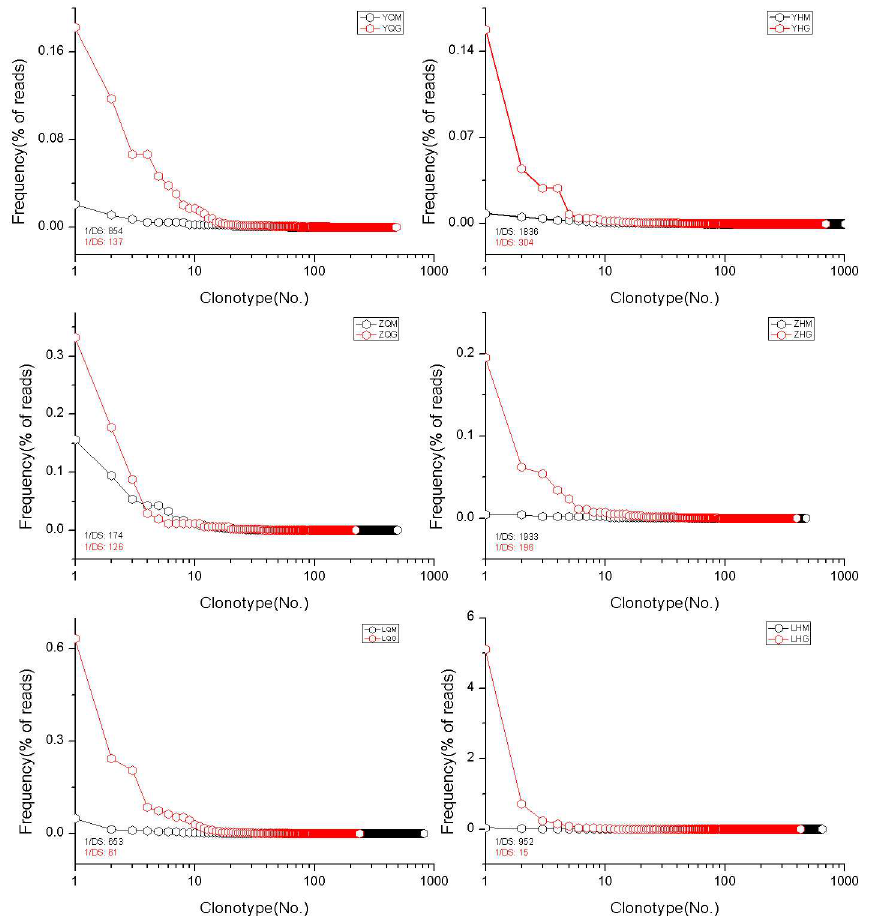
Fig 2. The diversity of repertoiresof IgM and IgG before and after immunization with HBV vaccinesin 3